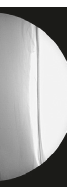
Figure 2: Intraoperative lateral radiograph showing placement of syndesmotic screws and the undamaged previously placed tibial